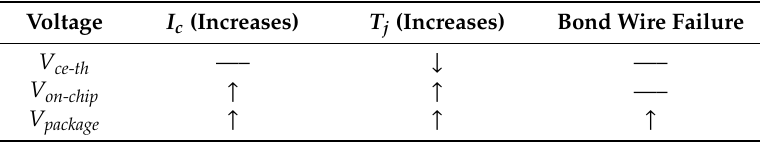
Table 2. Di ff erent factors in the components of on-state